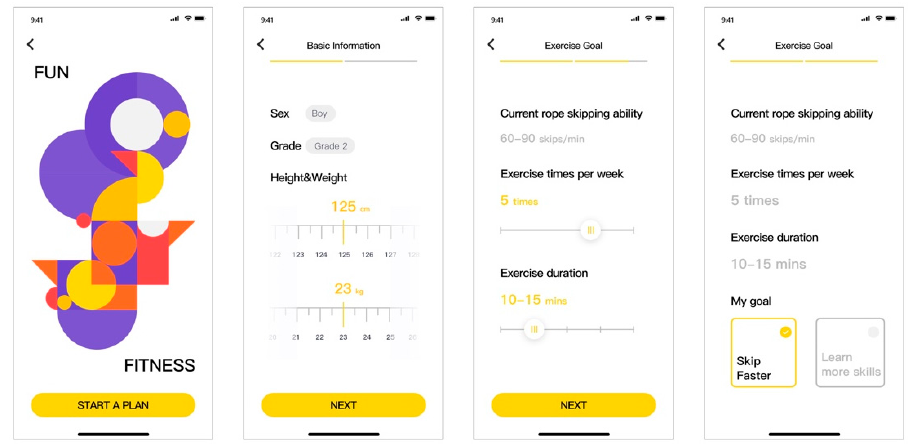
Figure 9. Plan formation interface.